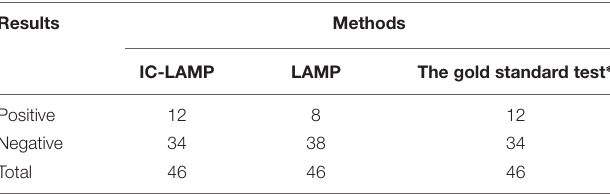
TABLE 1 | Comparison between IC-LAMP, LAMP, and traditional biochemical identification and serum agglutination